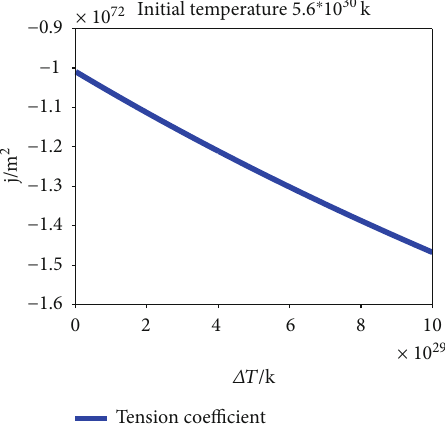
Figure 2: Shows the relationship between the tension coe ffi cient of the membrane of the black hole and temperature di ff erence with an initial temperature 5 : 6 × 10 30 k (for the rational, we choose such a high temperature, see